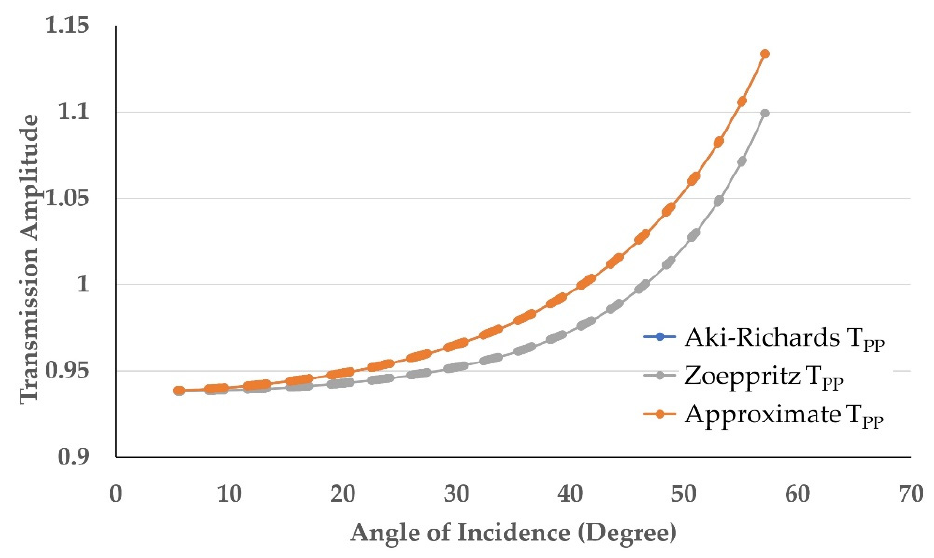
Figure 3. Fitting angle–amplitude (T PP ) data of CTP 38 in the oil reservoir. Table 3. Values of the fitting parameters for CTP 38 in the oil reservoir.